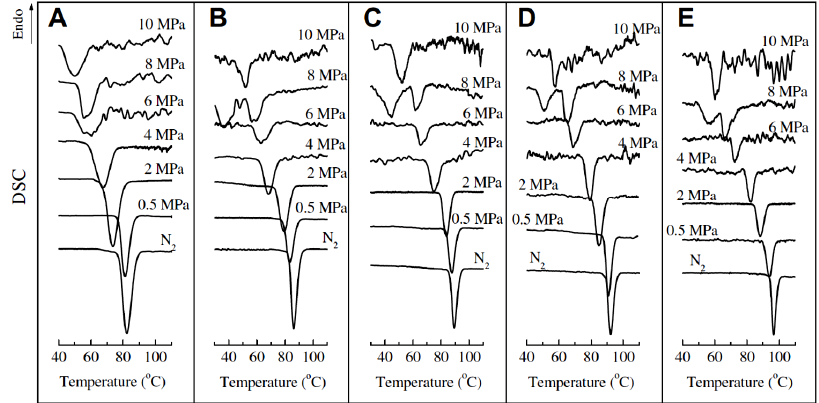
Figure 14. DSC diagrams recorded during non-isothermal melt-crystallization processes of iPBu under atmospheric N 2 and CO 2 at various pressures. The cooling rates are: ( A ) 5 ◦ C/min; ( B ) 2.5 ◦ C/min; ( C ) 1 ◦ C/min; ( D ) 0.5 ◦ C/min; and ( E ) 0.25 ◦ C/min. Reproduced with permission from Ref. [91], copyright 2011 Elsevier